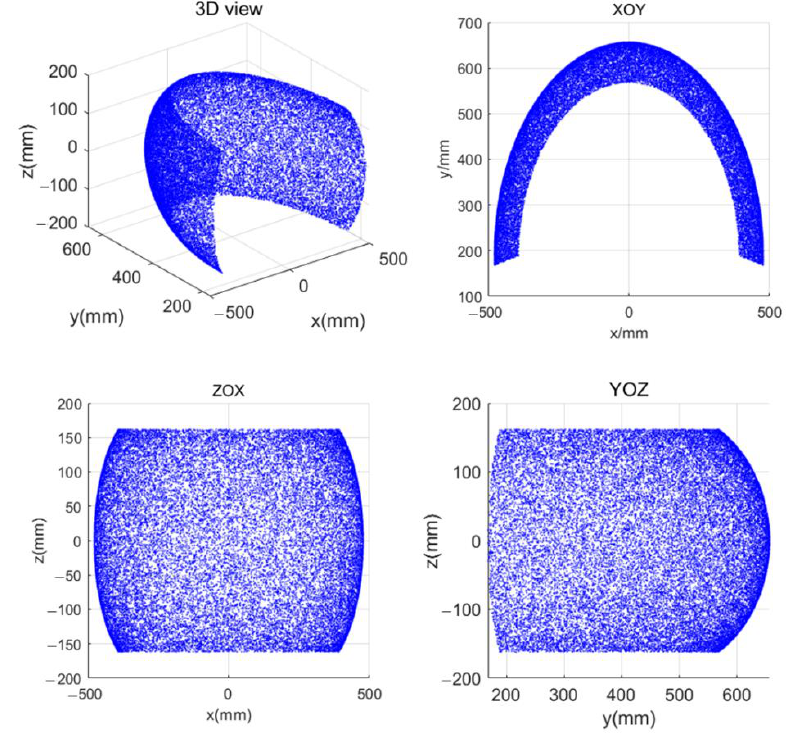
Figure 10. The working space of the CDFM.